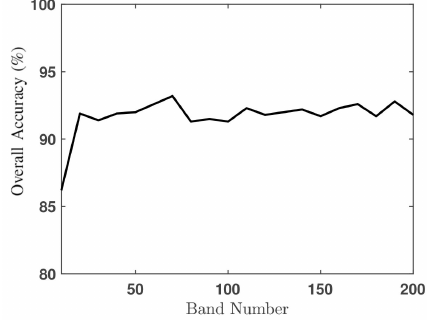
Figure 17. Effect of band number in BSCNN on overall